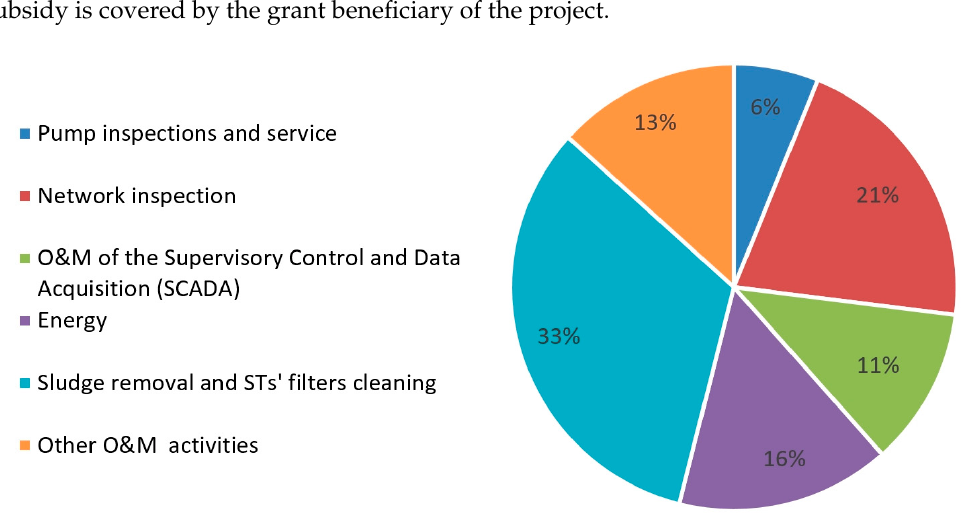
Figure 15. Elements of O&M of SDGS system cost (except for depreciation costs) in Zolkiewka commune.